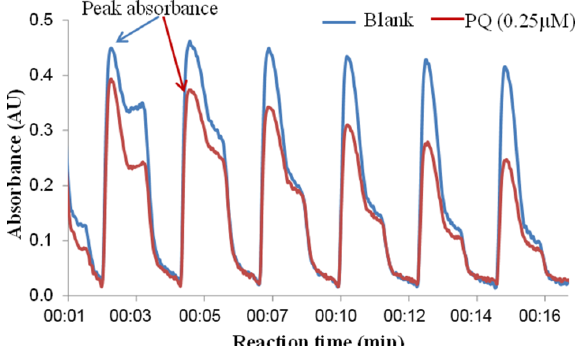
Figure 3. Peak absorbance for water blanks and PQ (0.25µM) after rinsing injection with